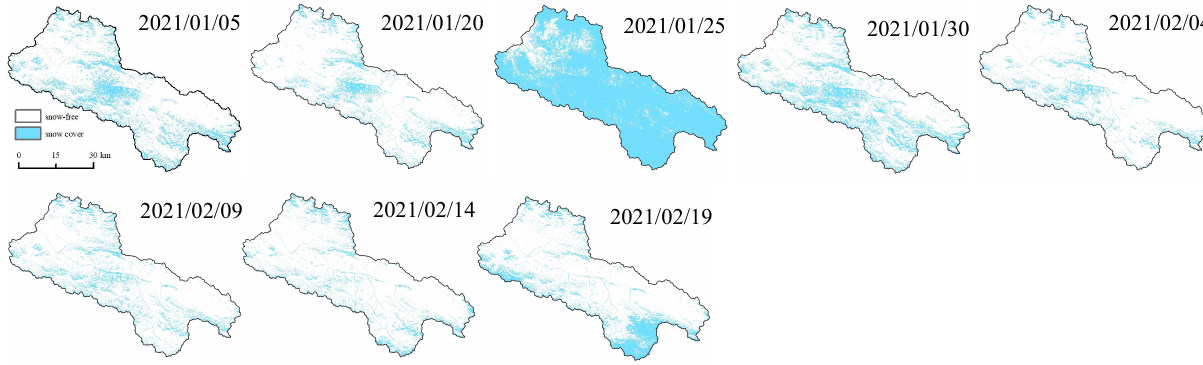
Figure 7. Spatial variation of snow cover during stable period (2021/01-2021/02).